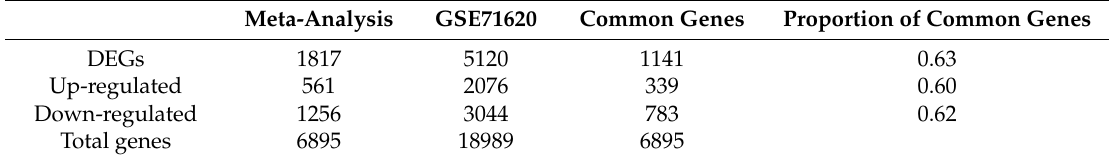
Table 2. Summary of number and direction of the change of DEGs detected in the analysis.